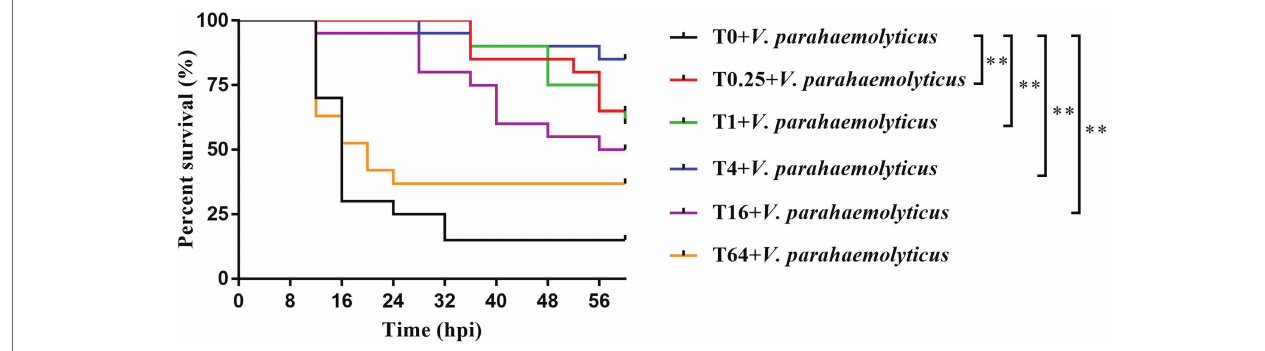
FIGURE 2 | Survival rates of TWS119 fed P. vannamei after Vibrio parahaemolyticus infection. The experiments were performed two times with identical results. Differences in survival levels between treatments were analyzsed by Kaplan-Meier plot (log-rank χ 2 test). Significant differences in survival rate were marked with asterisks, ** indicates p <